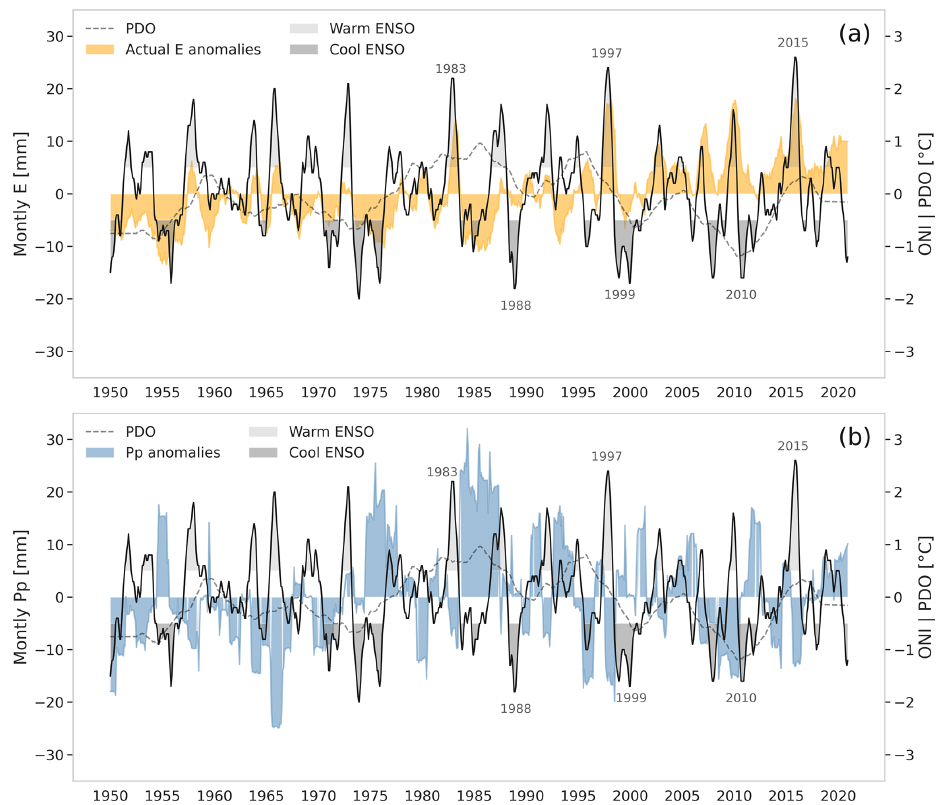
Figure 12. (a) Monthly evaporation (E) anomalies compared to ONI and PDO indices. (b) Monthly precipitation (Pp) anomalies compared to ONI and PDO indices. Anomalies are calculated using the difference between the entire period mean, and 12-month moving averaged anomalies. Evaporation and precipitation anomalies are shown in colors: the ONI with a solid black line, highlighting the warm and cool phases, and PDO with a dashed